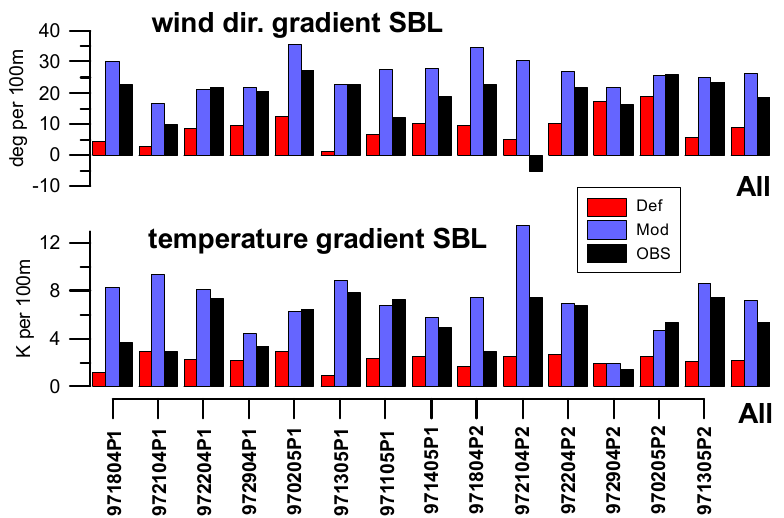
Figure 12. Gradients in the ABL from aircraft profiles (black) and simulations (def: red, mod: blue) for all KABEG flights (see Table 1) and as an average for all profiles (All). Upper panel : Wind direction gradient in the lowest 200 m. Lower panel : Potential temperature gradient in the lowest 200 m (all values per 100 m). x axis as in Figure 11.